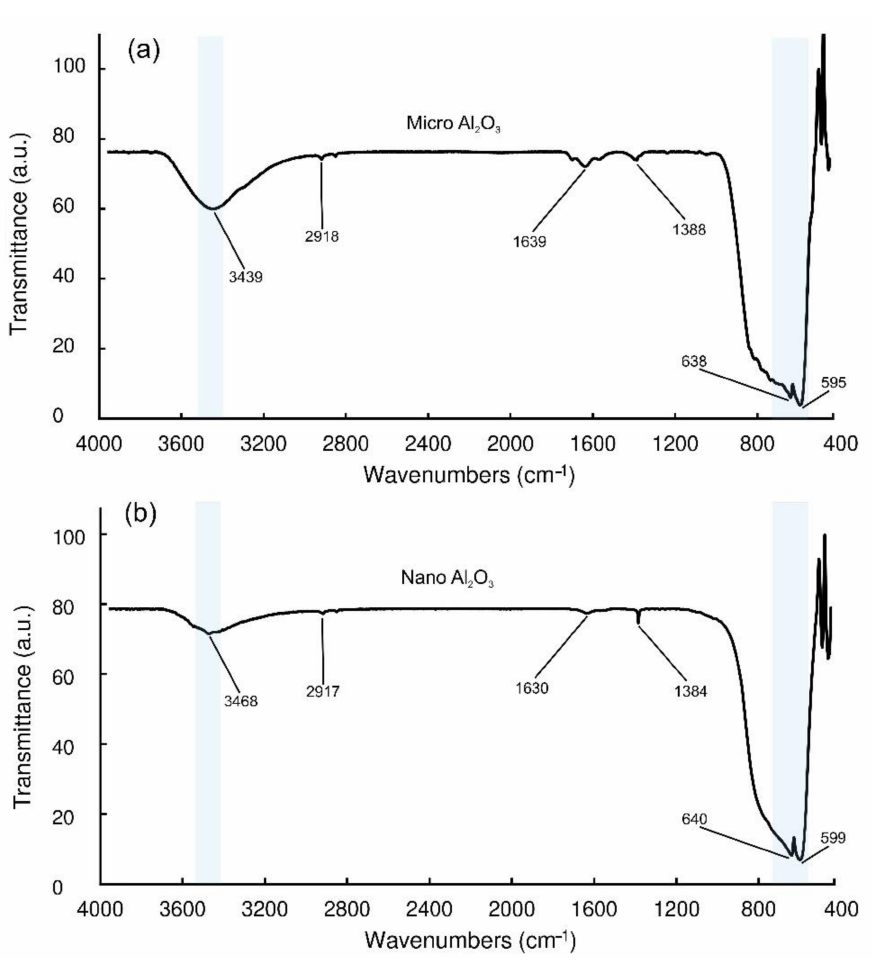
Figure 3. Fourier transform infrared spectroscopy (FTIR) spectra of ( a ) micro-Al 2 O 3 and ( b ) nano- Al 2 O 3 .